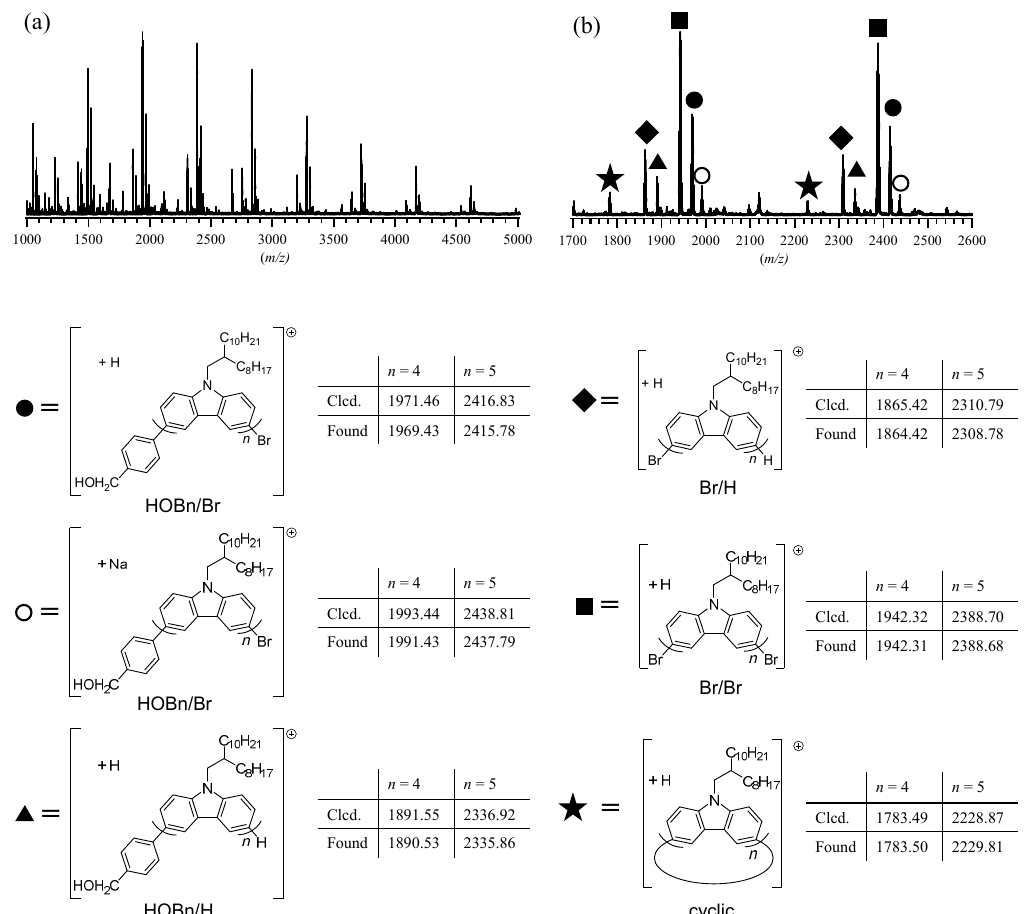
Figure 2. MALDI-TOF mass spectral analysis of HOCH 2 − 3,6-PCz obtained from run 1 (Table 1). ( a ) MALDI-TOF mass spectrum. ( b ) Expanded spectrum ranging from 1700 to 2600 Da.